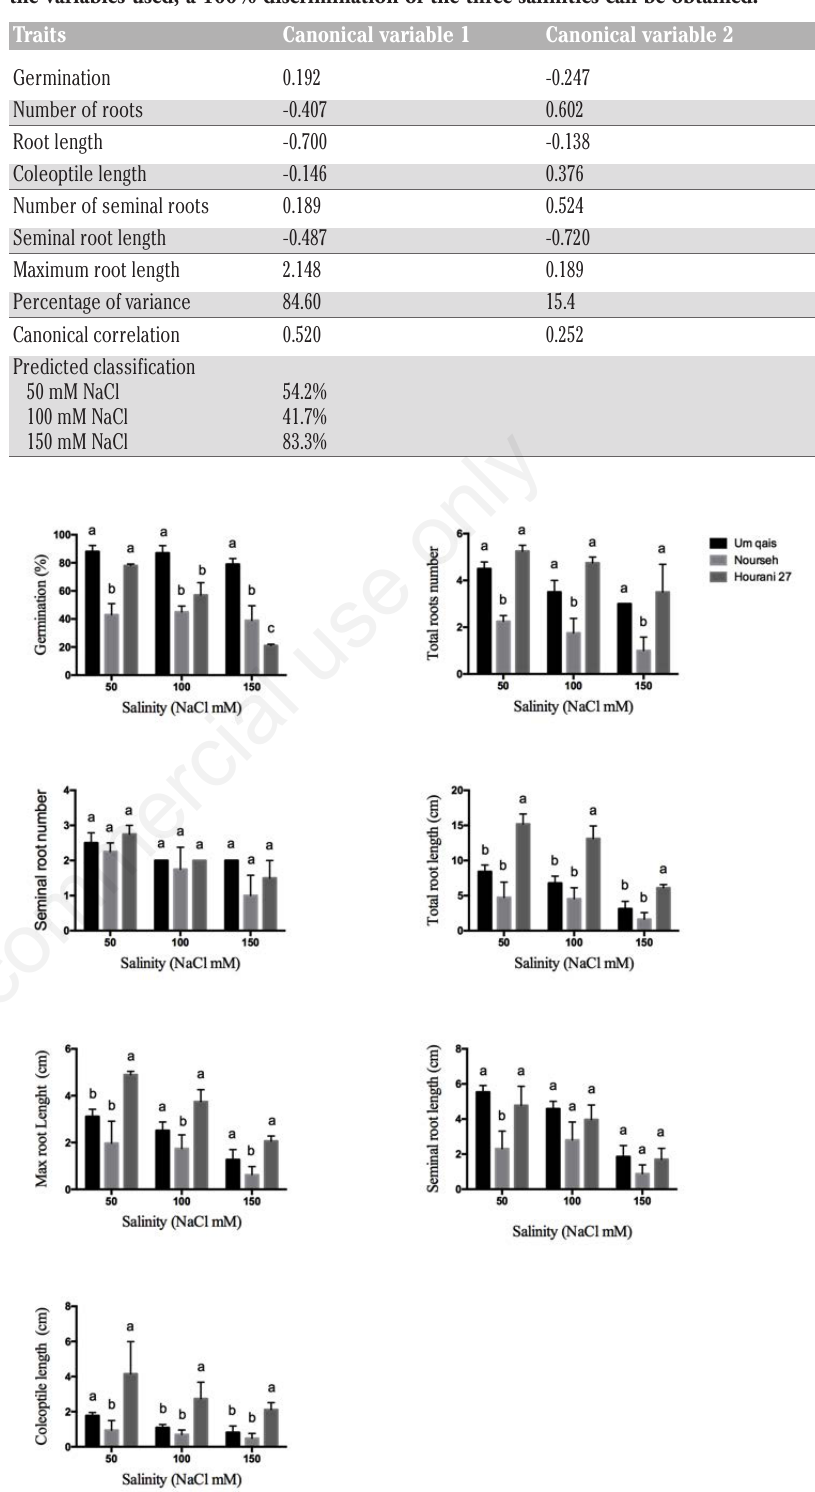
Table 2. Canonical variable loadings, percentage of variation, and canonical correlation results of a DA of the germination and root architectural traits for all genotypes of durum wheat subjected to different salinities. Unstandardized coefficients from the discriminant functions and predicted classifications are presented: a 100% prediction means that, with the variables used, a 100% discrimination of the three salinities can be